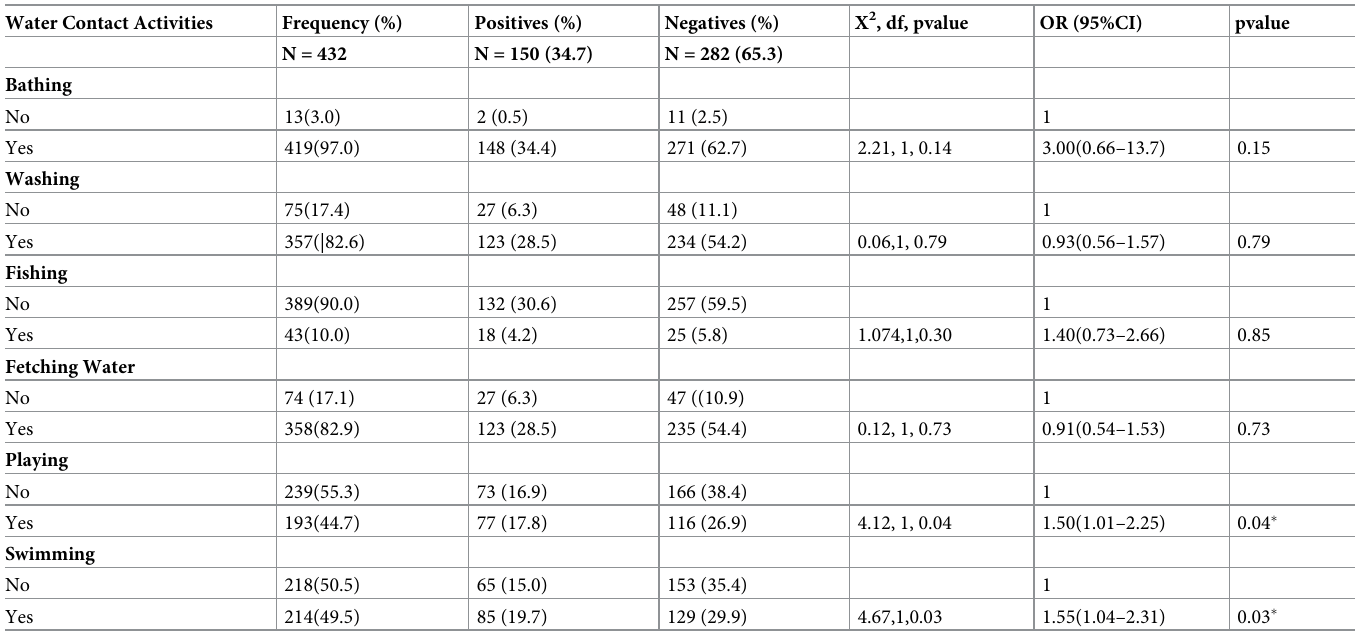
Table 4. Water contact activities and prevalence of schistosomiasis.